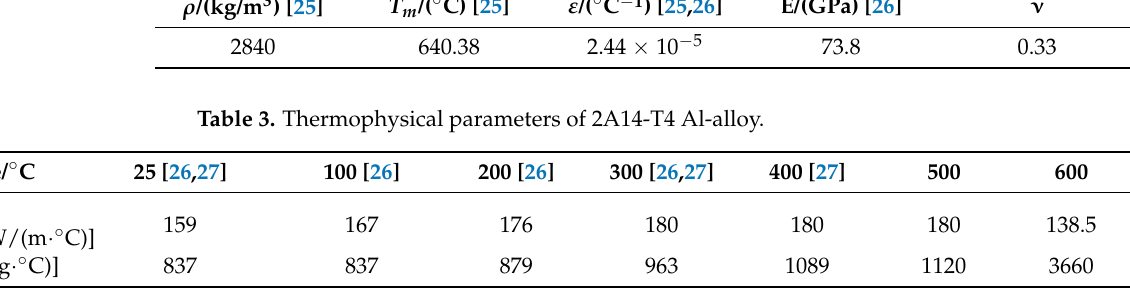
Table 2. Physical property parameters of 2A14-T4 Al-alloy.